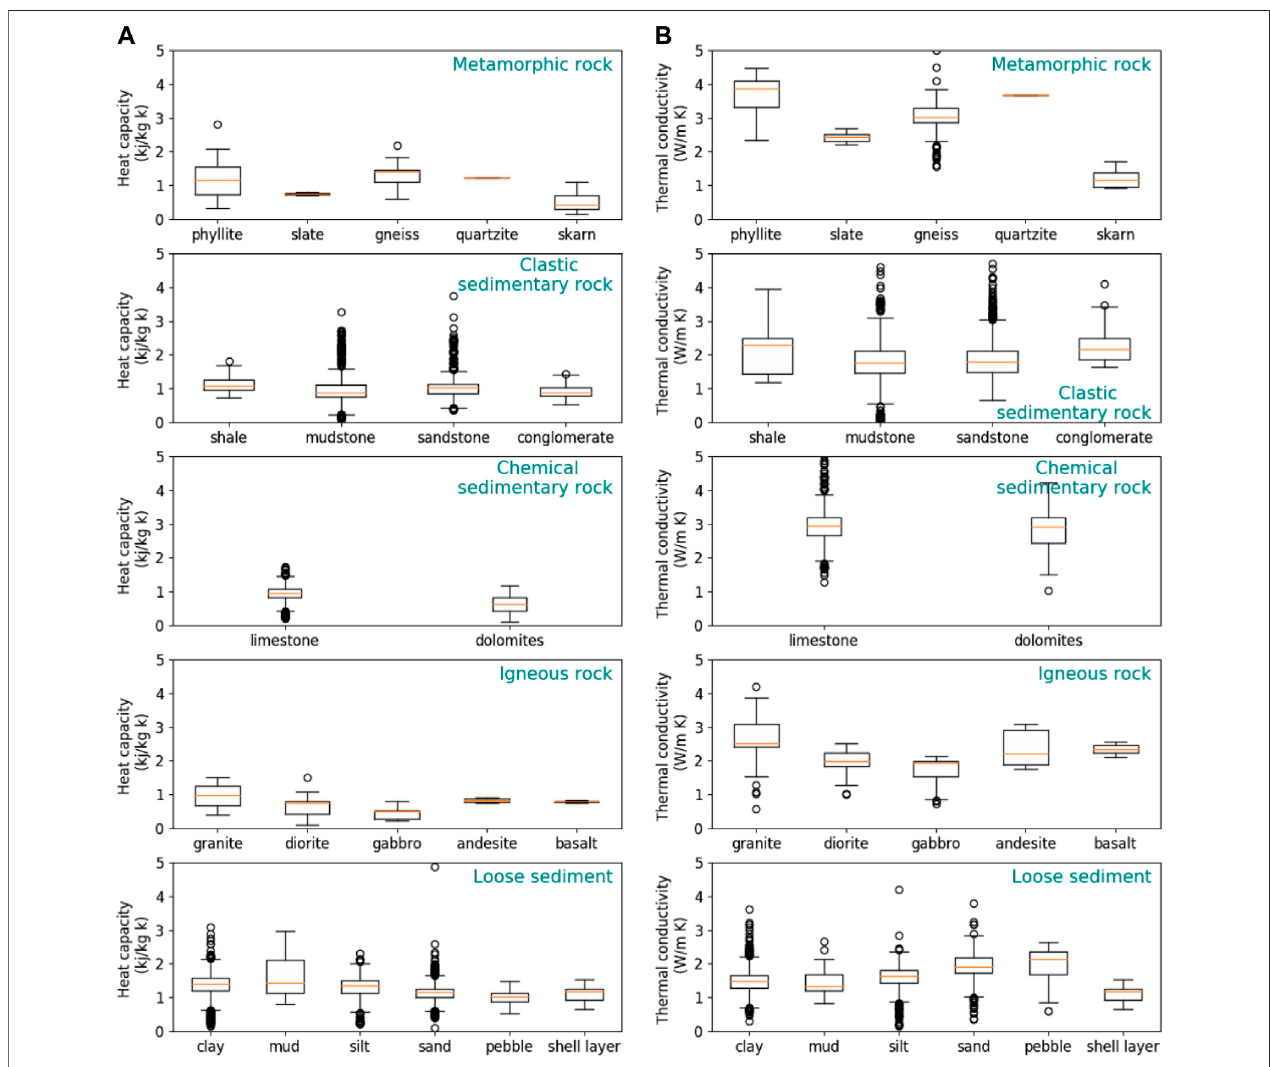
FIGURE2| Boxplotsofheatcapacity (A) andthermalconductivity (B) ofrockandsoilsamples,havingdifferentlithology.(Boxesrepresentthequartile,redlinesthe median, whiskers – maximum data range, black circles the outliers.).